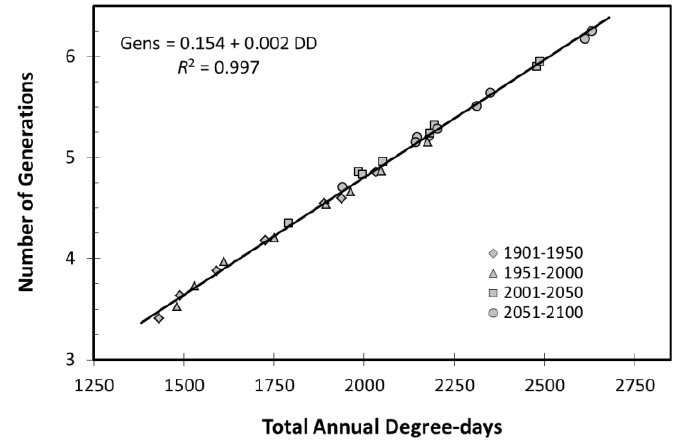
Figure 7. All changes in the dynamics of the crop-pest system can be traced to the changes in the heat accumulations by the pest insects. The number of potato leafhopper generations per year is directly proportional to the total degree-days accumulated above its developmental threshold of 8.5 ◦ C. With the exception of univoltine stalk borer, all species exhibited an increase in generations in proportion to the accumulated degree-days.